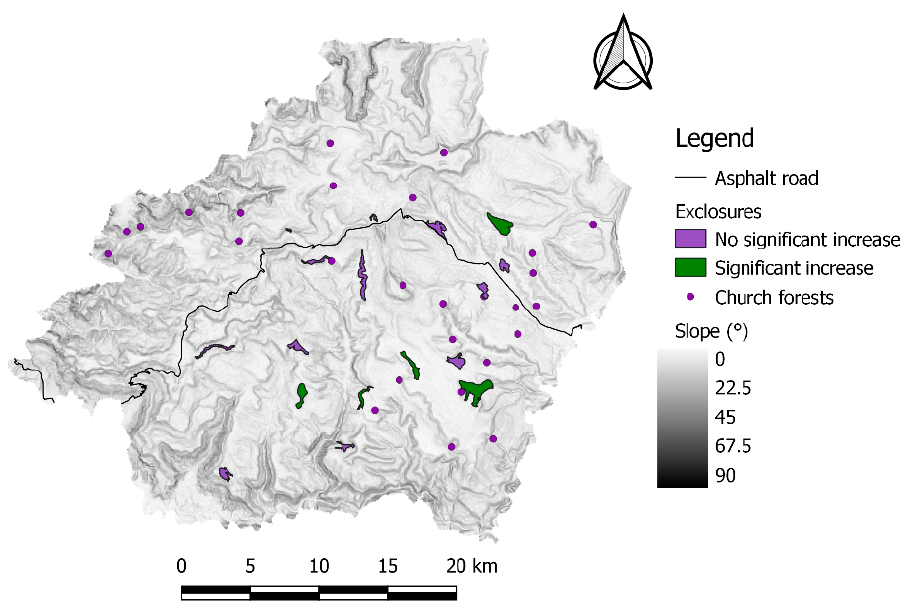
Figure A7. Slope of the Degua Tembien district, together with the location of the 17 exclosures and 25 church forests included in the analysis.